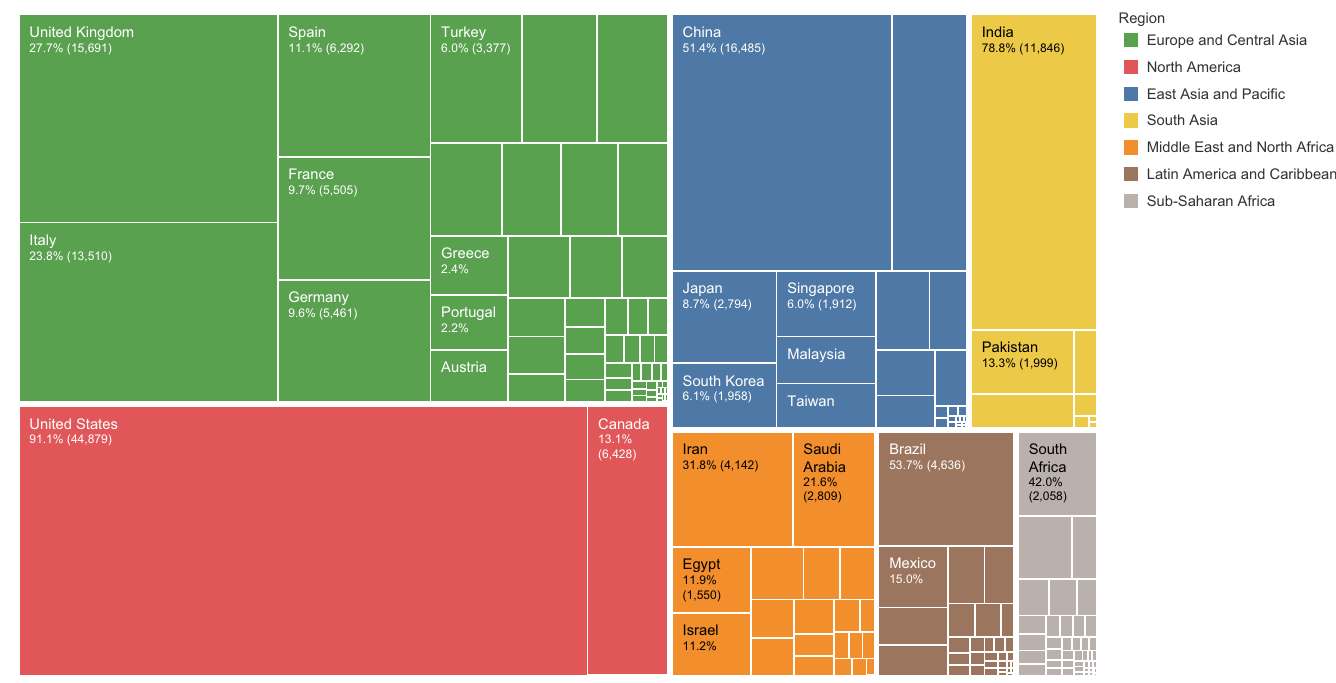
Fig 3. Share of countries in publications within their corresponding World Bank regions.